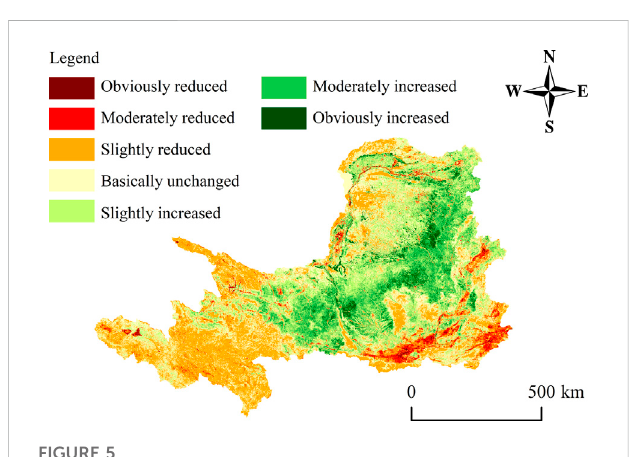
FIGURE 5 Spatial distribution of trends in the NDVI.